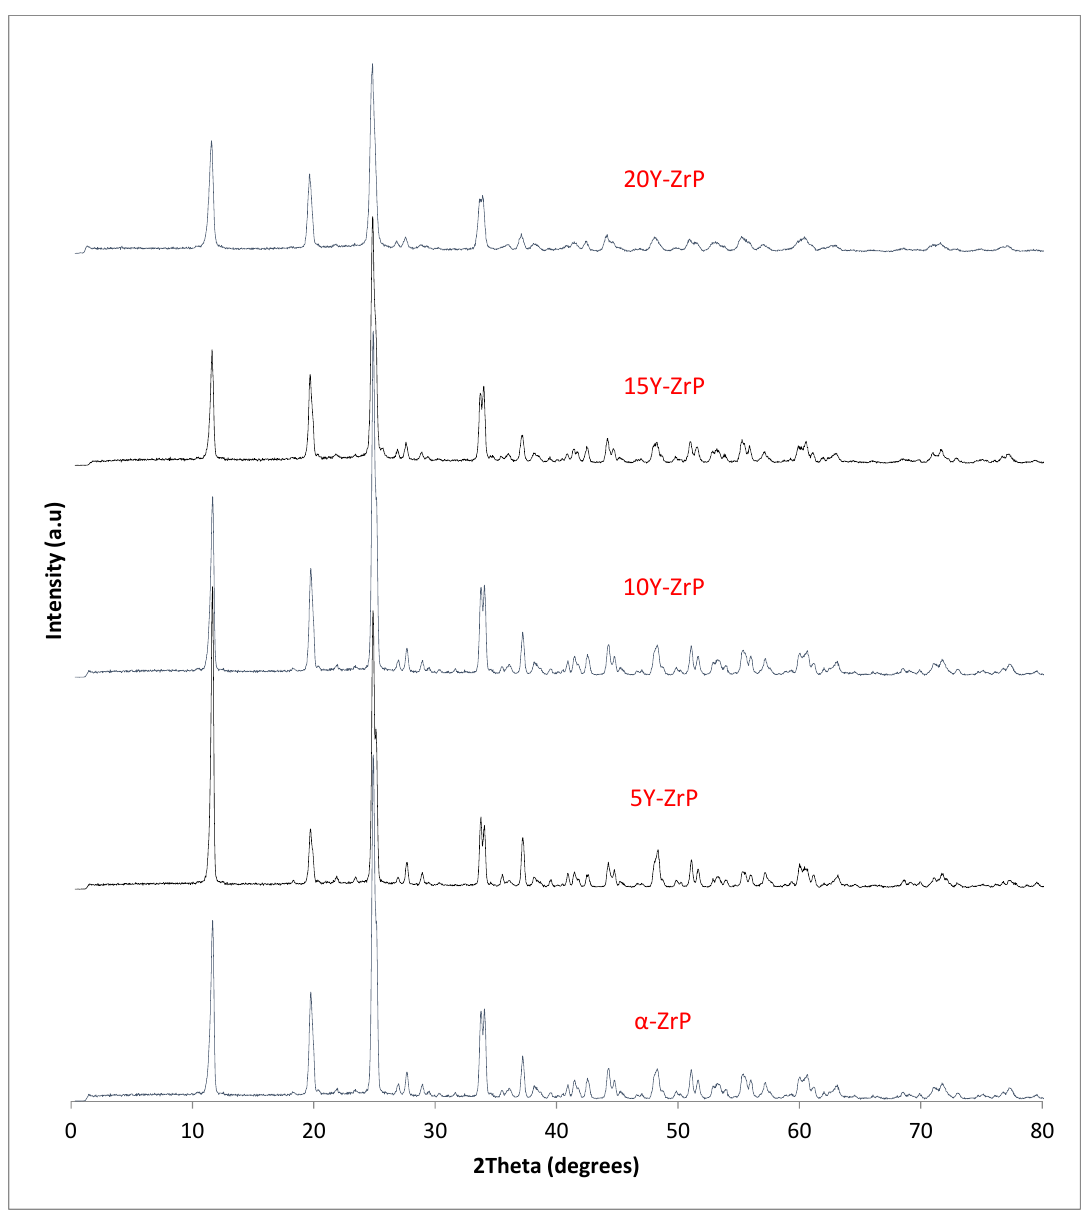
Figure 1. XRD patterns of conventionally synthesised Y–ZrP samples and α -zirconium phosphate.